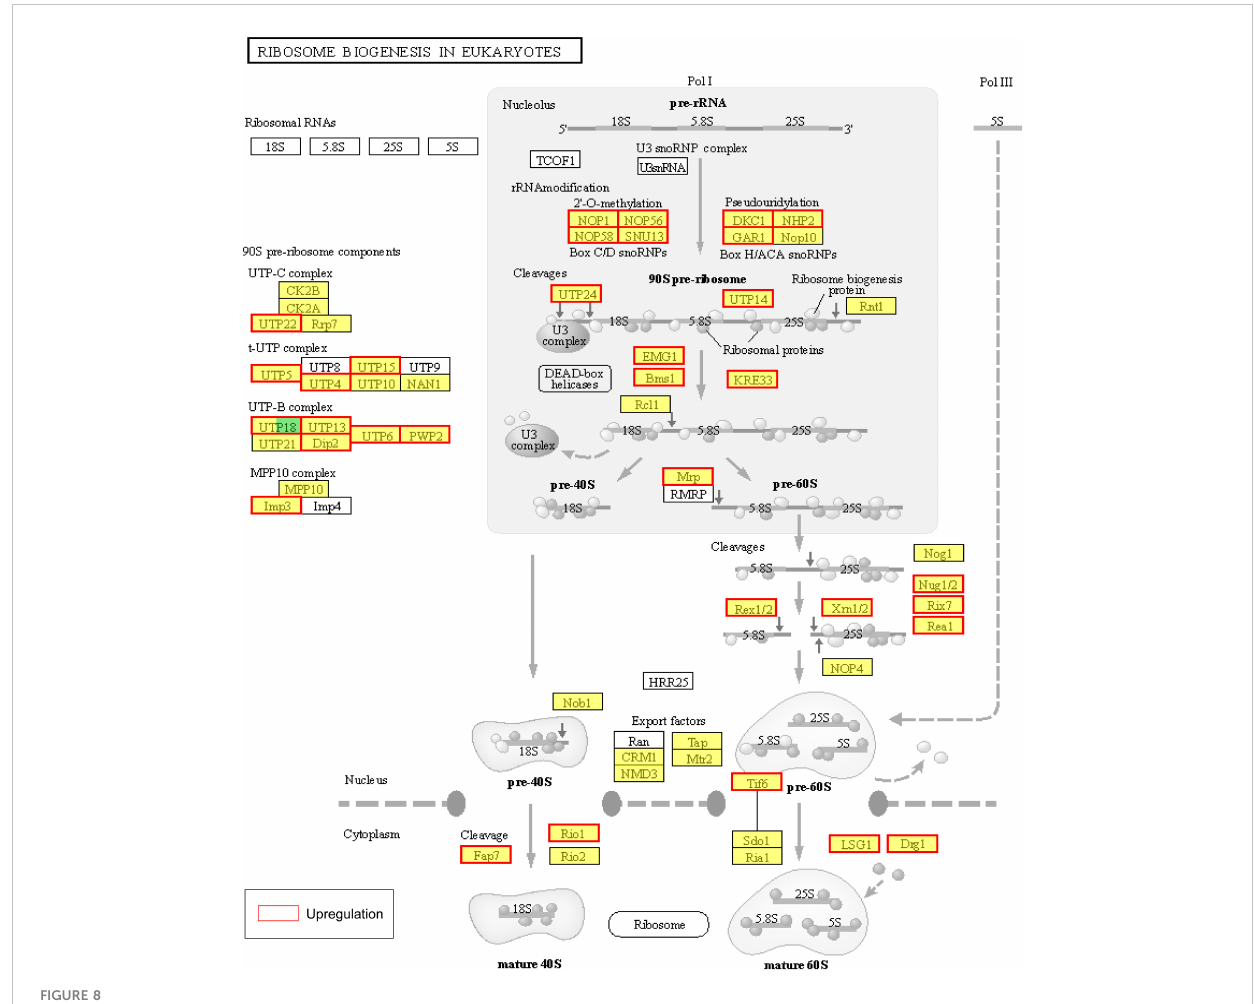
FIGURE 8 Changes of ribosome biogenesis during LO vs